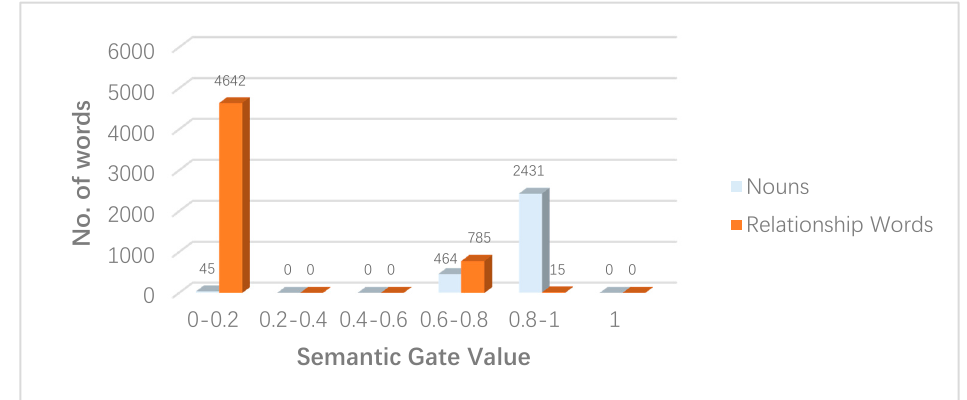
Figure 17. E ff ect of semantic gate with sigmoid activation. Figure 17. Effect of semantic gate with sigmoid activation.